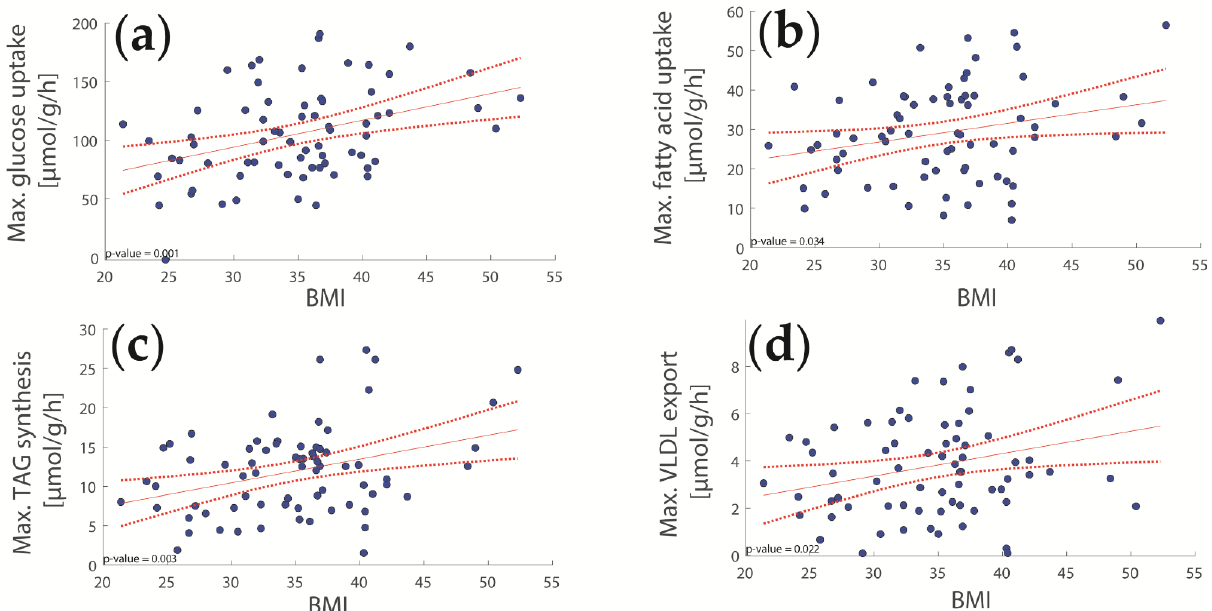
Figure 2. Relationship between the body mass index (BMI) and hepatic metabolic functions. ( a ) Glycolysis; ( b ) Fatty acid uptake; ( c ) TAG synthesis; ( d ) Lipoprotein synthesis.